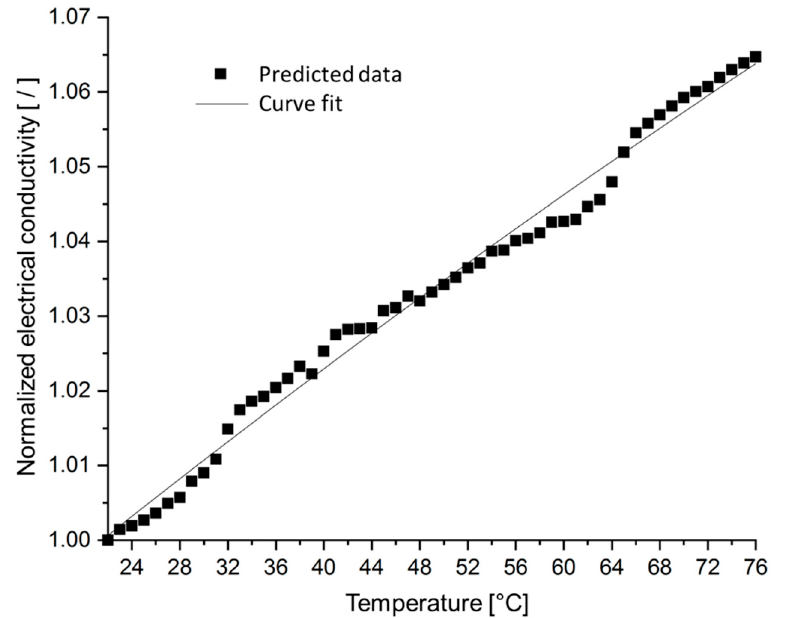
Figure 19. Normalized electrical conductivity, considering thermal expansion and electron activity effects, versus temperature for silver/epoxy nanocomposites with a particle size of 3 nm, tunneling distance of 1.5 nm, and filler loading of 30 vol%.